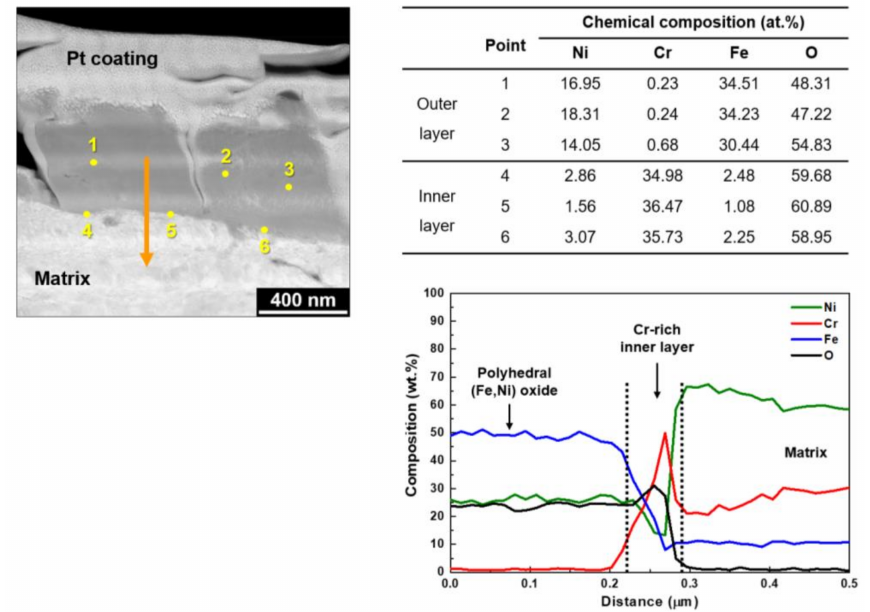
Figure 5. STEM image and EDS analyses of oxides grown on Alloy 690 under the Case #1 condition.